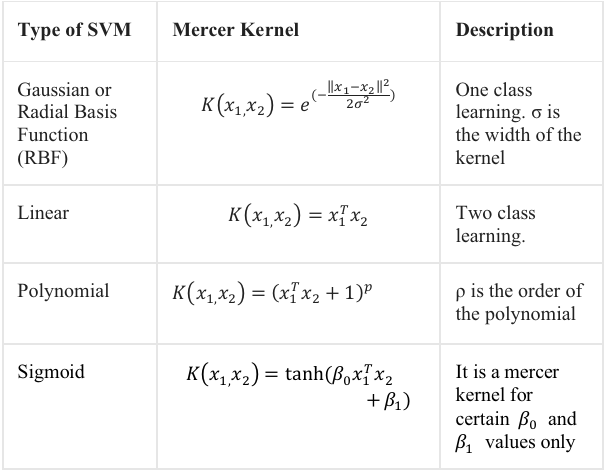
Fig. 5. Two-stage SVM-SqueezeNet Network for classification, Range-Angle Range-Doppler estimation, , and clutter/jammer rejection TABLE I. D IFFERENT TYPES OF K ERNEL